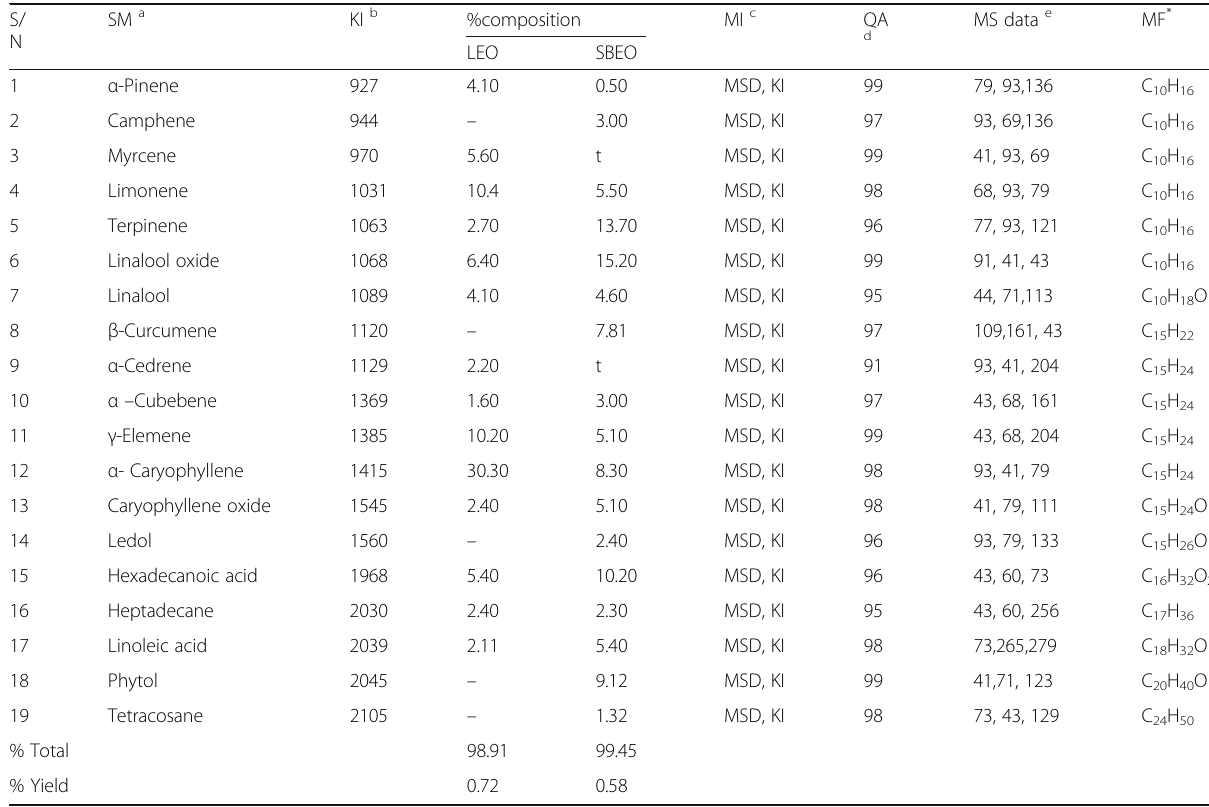
Table 10 Chemical profiles of secondary metabolites in A. indica essential oils S/